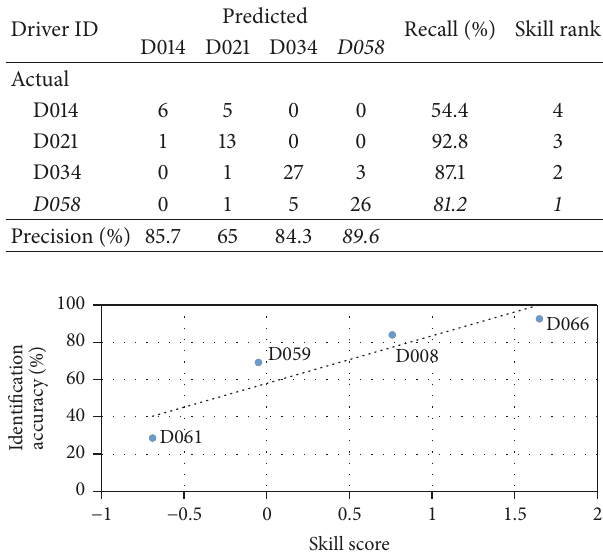
Table 7: Aggression and skill score for drivers. Table 8: Confusion matrix on group 1 (G1) of drivers.